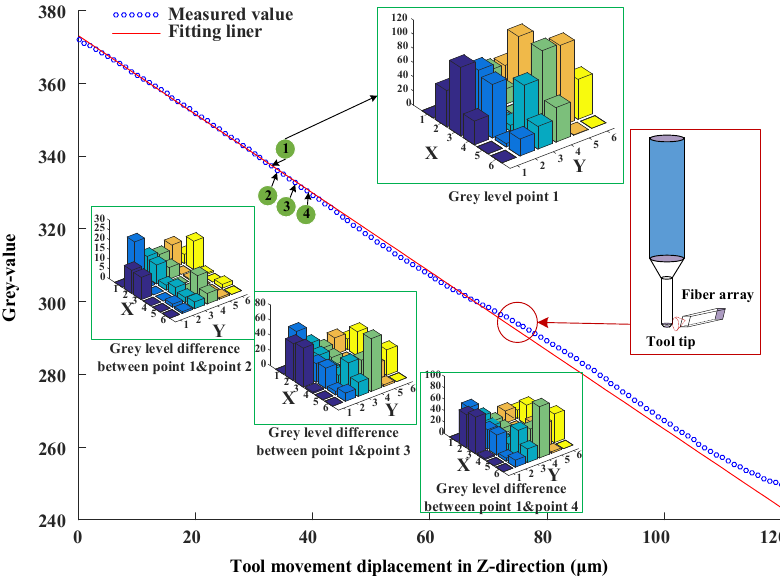
Figure 8. Output in terms of grey values vs. tool displacement change in z-direction.